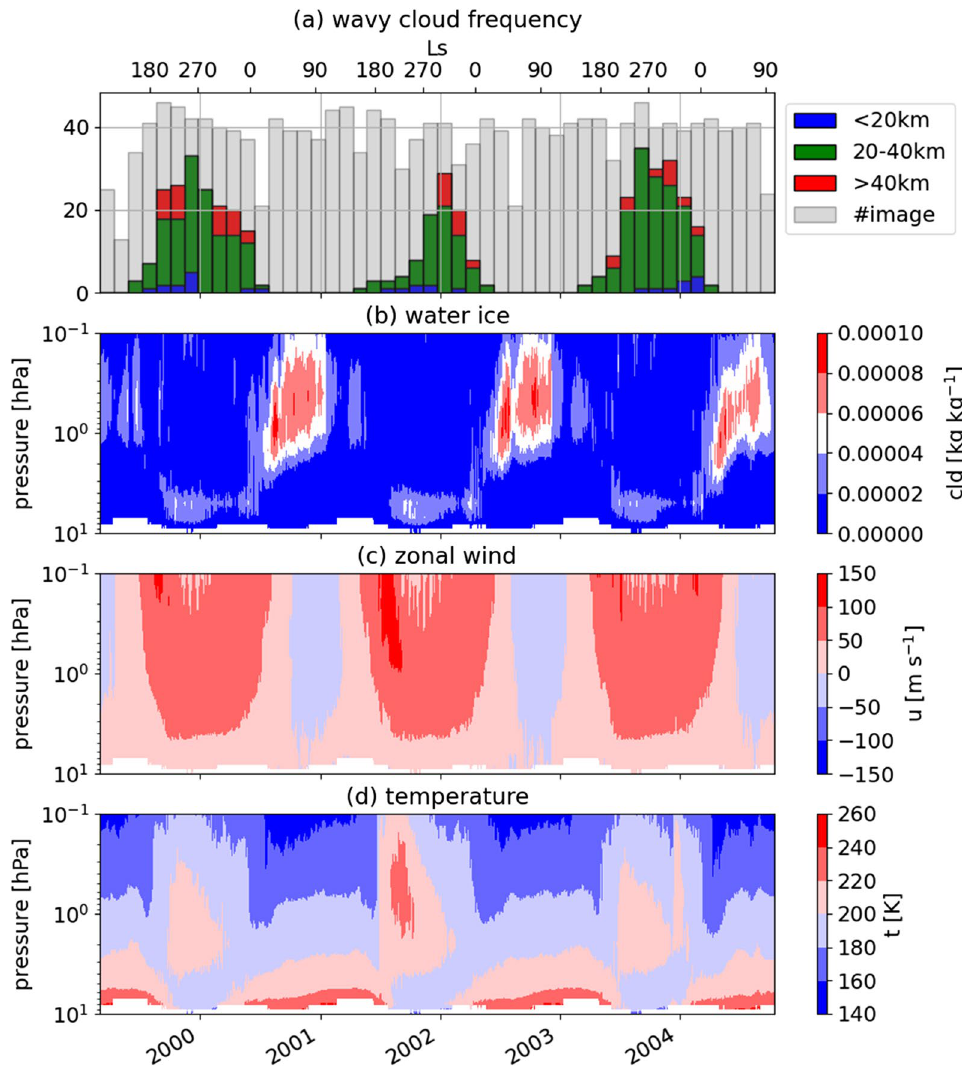
Fig. 4 The seasonal variabilities in the number of cloud trains and the background atmospheric variables. a The number of cloud trains, b water ice mixing ratio, c zonal wind, and d atmospheric temperature in the target area, WAP, are displayed. The gray bars in Panel a indicate the number of the MOC blue images available for this study. The blue, green, and red bars indicate the numbers of detected cloud trains whose wavelengths are short, middle, and long, respectively. The variables shown in Panels b , c , and d are derived from the EMARS 1.0 and interpolated into the pressure